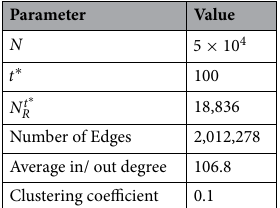
Table 3. Properties of the generated networks of the selected directed